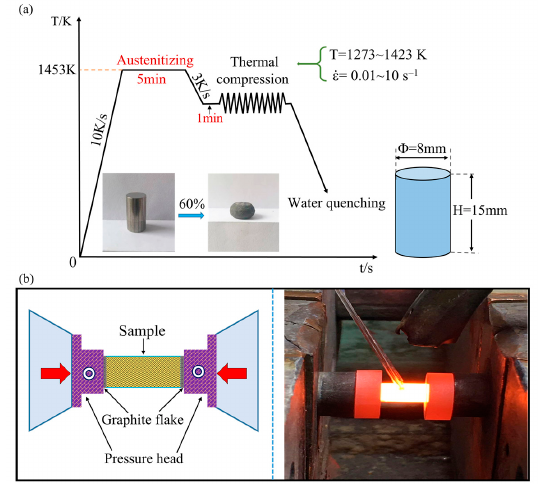
Figure 1. ( a ) Schematic of thermal compression conditions and ( b ) deformation testing.